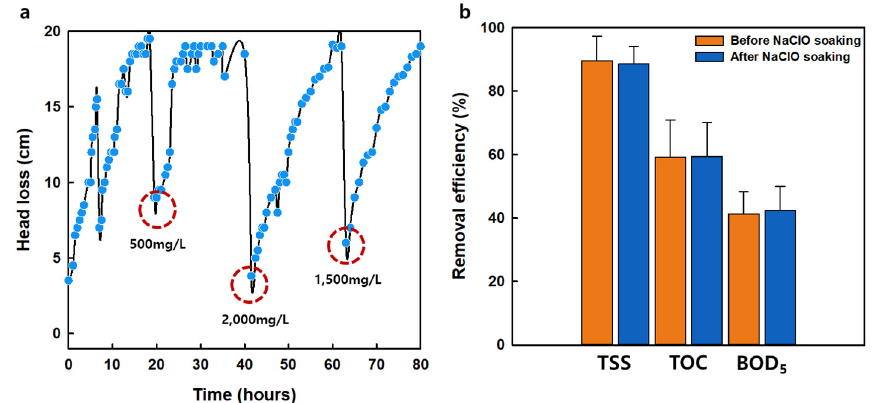
Figure 6. ( a ) Head loss recovery of the fiber media filter after chemical soaking with different concentrations of NaClO solution and ( b ) removal efficiencies of TSS, TOC, and BOD 5 from radial-type multifiber media filtration after chemical soaking with 2000 mg/L of NaClO solution.